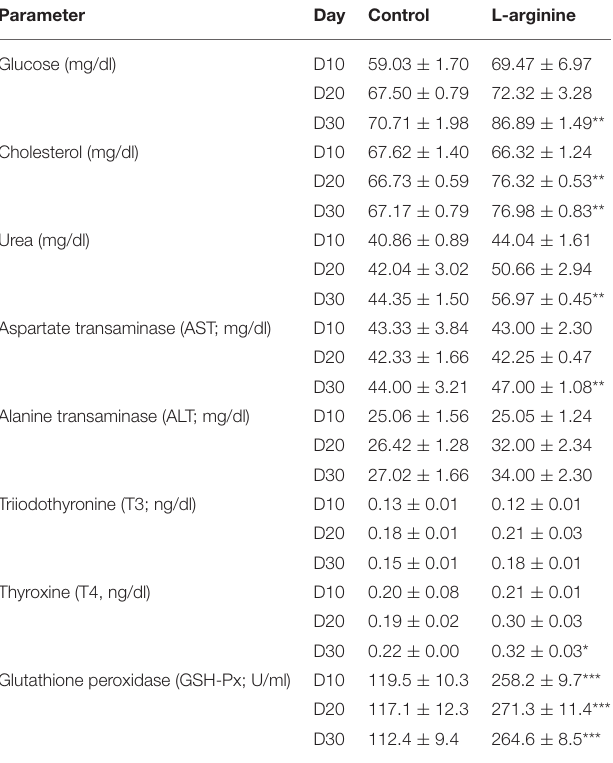
TABLE 3 | Serum biochemical parameters and glutathione peroxidation levels rams in the control and L-arginine treated rams at days 10, 20, and 30 ( n = 5/group, mean ±